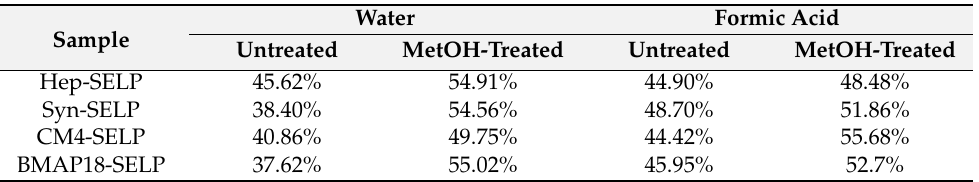
Table 1. Beta-structure content of AMP-SELP films, produced from water and formic acid solutions, after and before methanol (MetOH) treatment. Results presented as fractional distribution of total β -structure content determined by second derivative and Gaussian curve fitting.